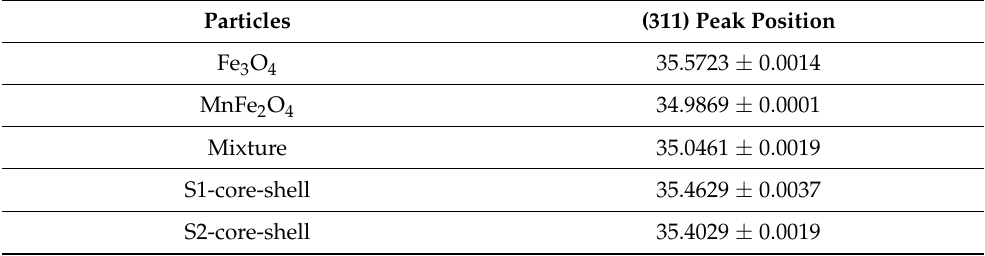
Table 2. The (311) peak positions obtained for the individual MnFe 2 O 4 and Fe 3 O 4 nanoparticles and core-shell nanoparticles.